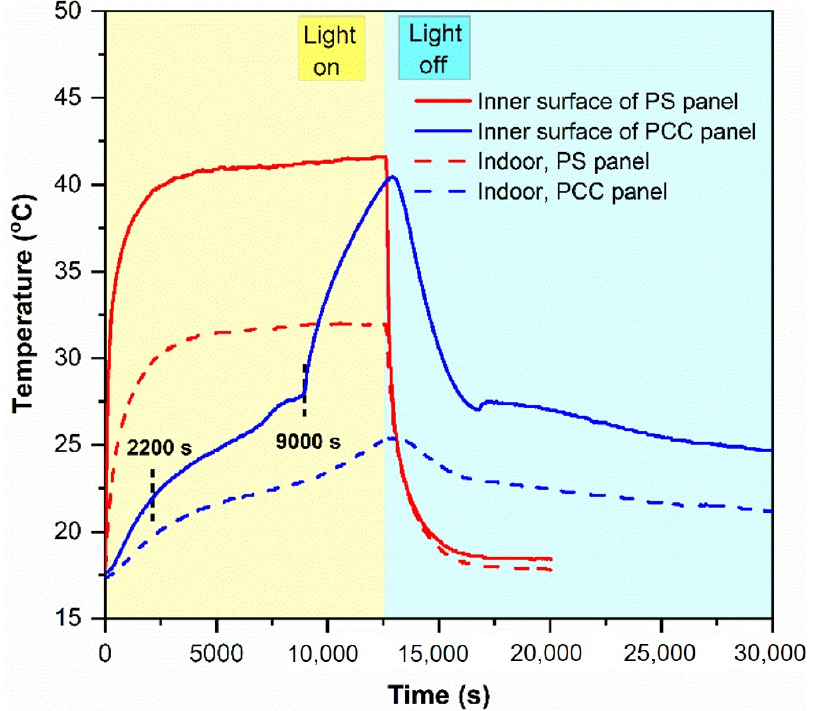
Figure 9. Temperature variations at different locations of the test room integrated with different